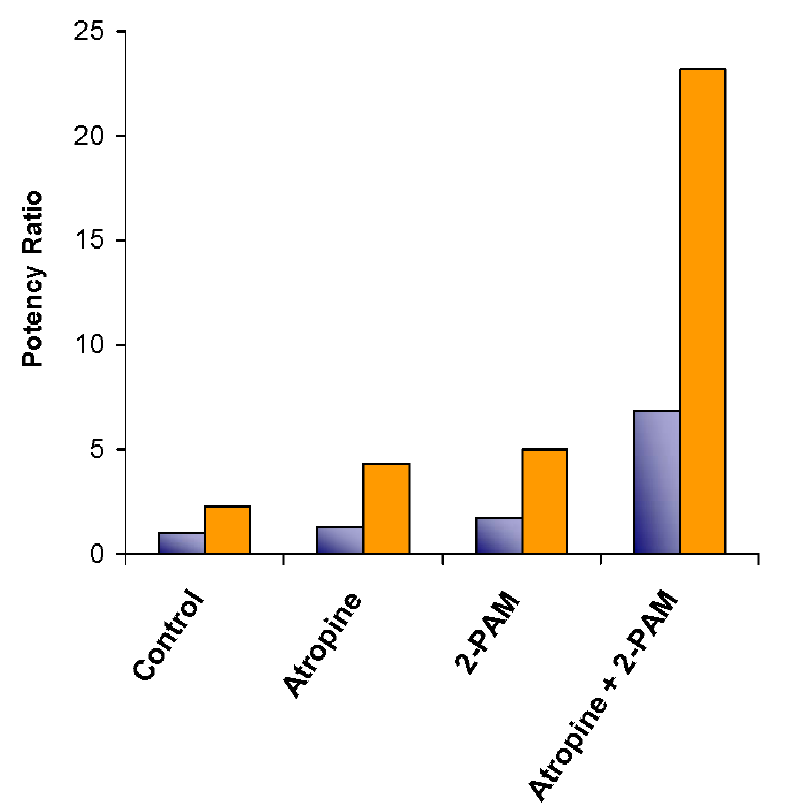
Figure 9. Potency ratios for the organophosphate antagonists atropine and 2-PAM without sterically stabilized liposomes ( ) and with sterically stabilized liposomes ( ) in mice. of the organophosphate diisopropylfluorophosphate (DFP) The potency ratio is the LD 50 with the antagonist divided by the LD of DFP without the antagonists. Adapted from 50 Petrikovics et al. with permission